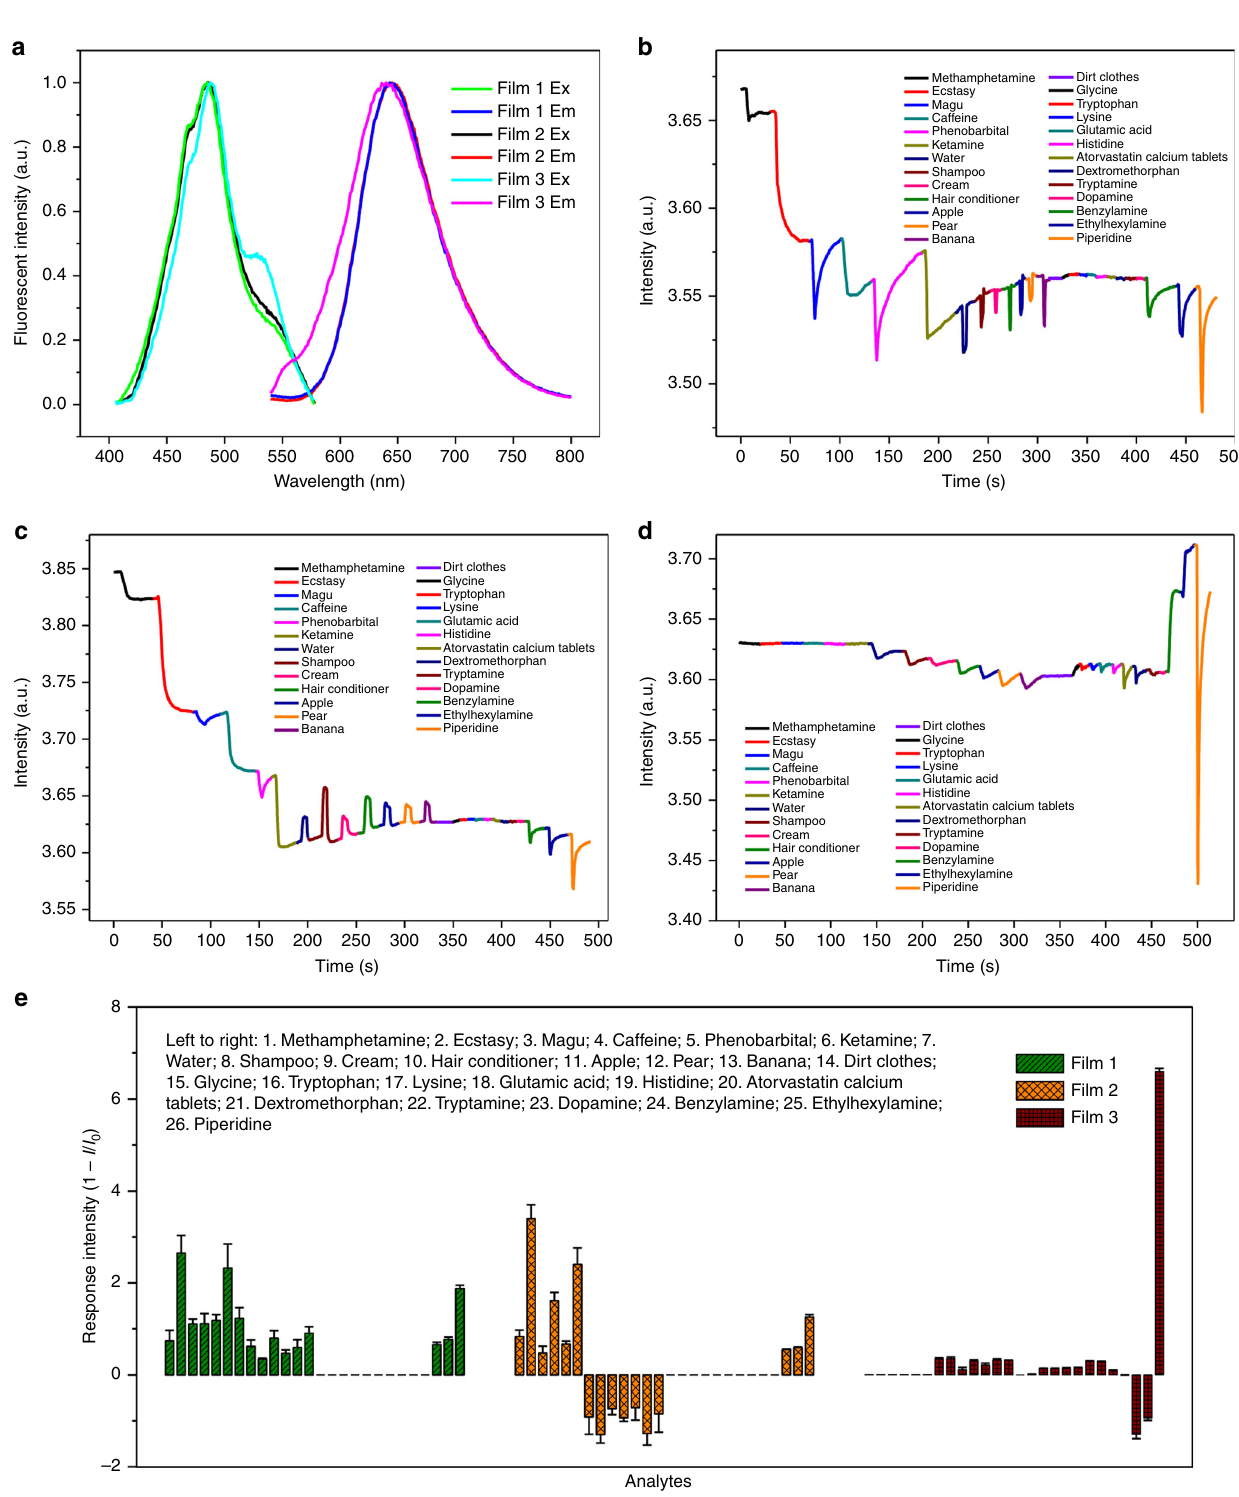
Fig. 3 Fluorescence spectra and sensing properties. a Fluorescent excitation and emission spectrum of the fi lms ( λ ex / λ em = 480/650 nm). Fluorescent intensity of fi lm 1 ( b ), fi lm 2 ( c ), or fi lm 3 ( d ) monitored at 650 nm ( λ ex = 480 nm) vs. time with exposure to different illicit drugs and different potential interferences. e Collective display of the sensing properties of the three fi lms from fi ve repetitive measurements. Note: (1) it is seen that different fi lms exhibit different response behavior to the analytes, and at the same time different analytes show different effects upon the fl uorescence emissions of the fi lms; (2) the results depicted in b – d are typical one of the fi ve repetitive tests; (3) the illicit drug samples tested are MAPA, ecstasy, magu, caffeine, phenobarbital and ketamine, and the potential interferences examined include water, toiletries (shampoo, cream, and hair conditioner), fruits (apple, pear, and banana), dirty clothes, and some amido-bond-containing organic compounds; (4) the error bars are drawn from the maximum